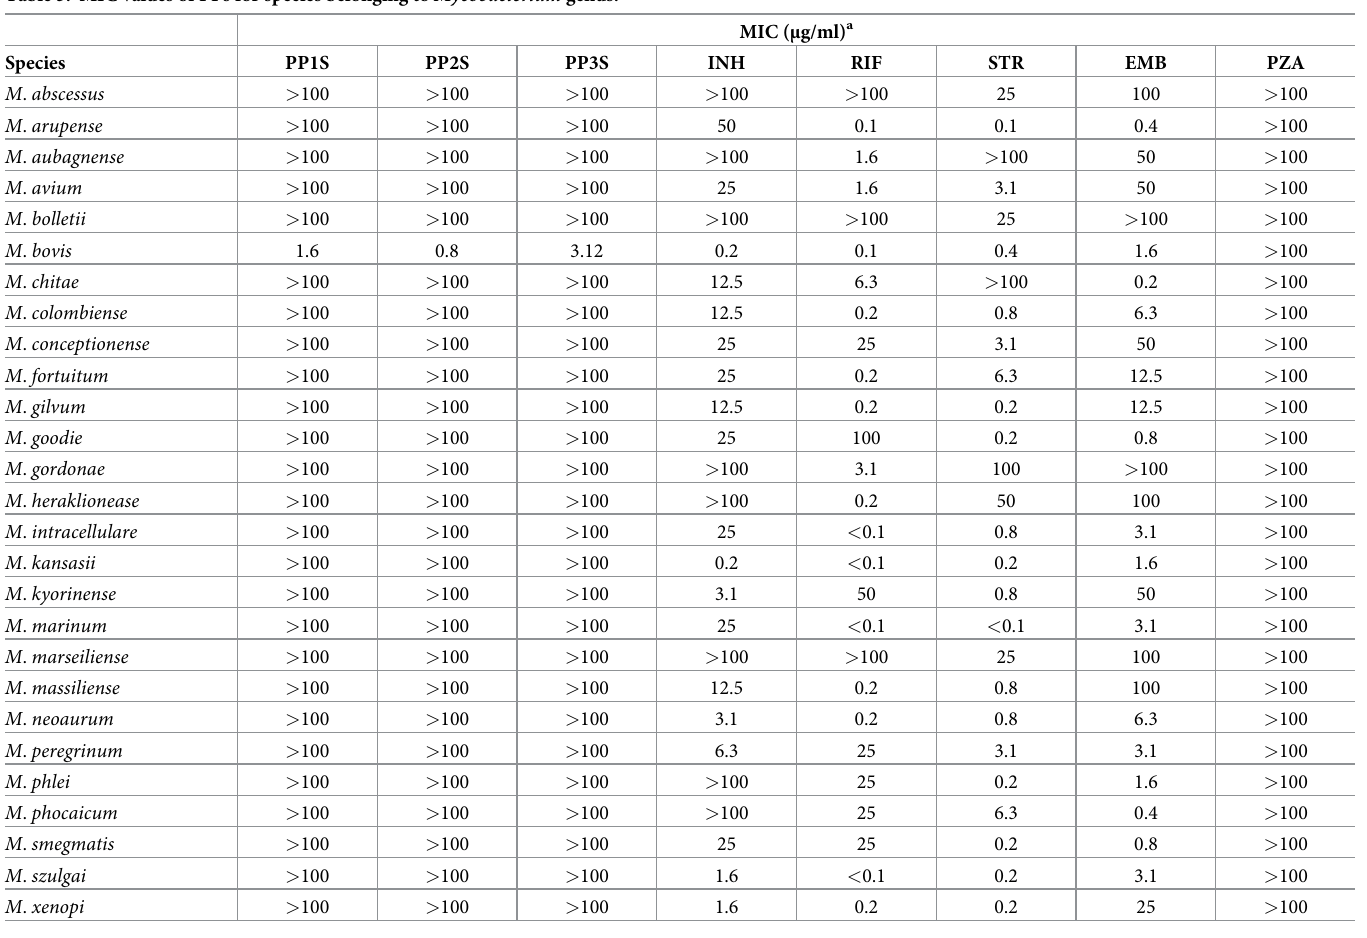
Table 3. MIC values of PPs for species belonging to Mycobacterium